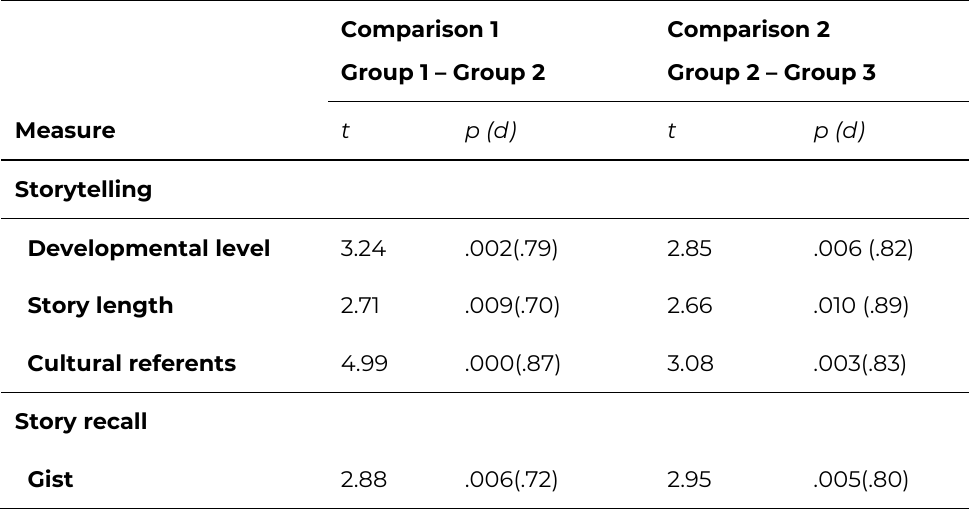
Table 6: Significant t-test comparisons for storytelling and story